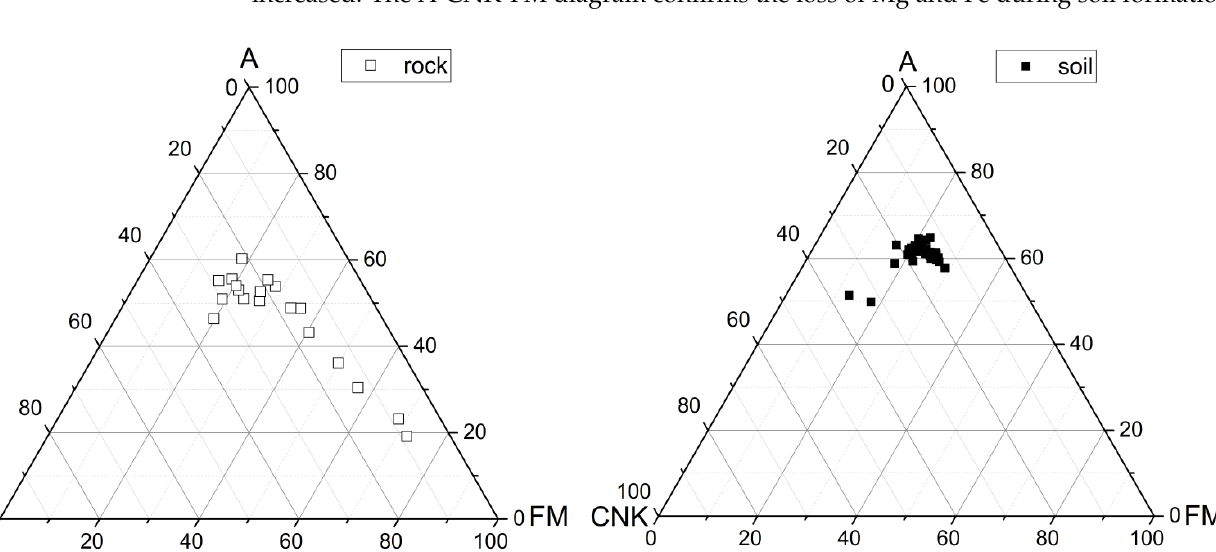
Figure 7. A M + -4Si-R 2+ diagram for rock and soil from the Mănăila area. The composition of dioctahedral 2:1 minerals in soil could be relevant for the as- sessment of the soil maturity [1,9]. Thus, the dioctahedral 2:1 minerals investigated by SEM-EDS were plotted on M + -4Si-R 2+ diagram (Figure 8) and their distribution pointed